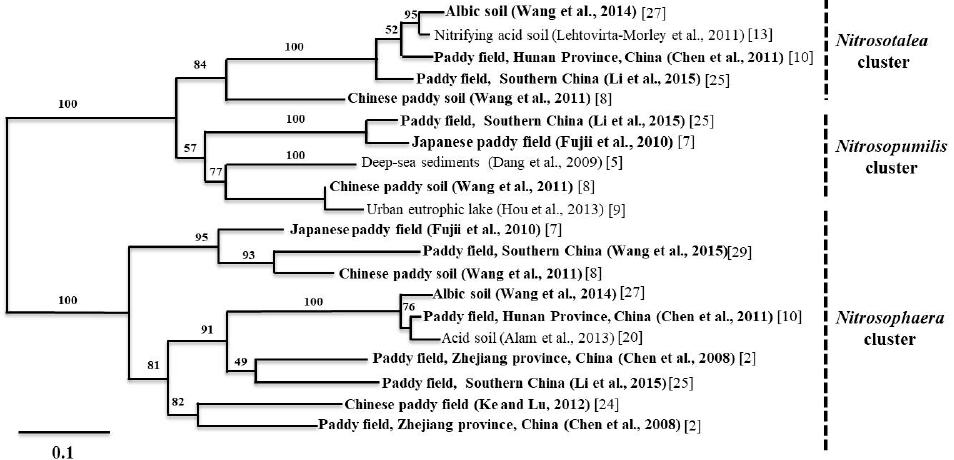
Figure 2. Neighbor-joining phylogenetic trees of AOA (ammonia-oxidizing archaea) based on amo A gene sequences found in different paddy soil types. The end nodes of the tree represent soil types. Please see the provided references for more details. In addition, please note that we performed bootstrapping to yield 1000 replicates at each